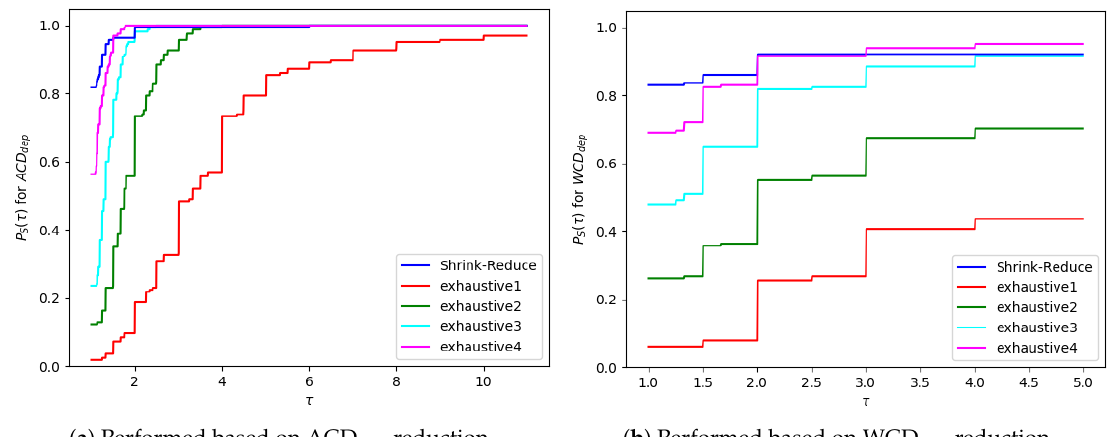
Figure 17. Results for all action replacement experiments. When τ is further increased, there is no change in P s ( τ ) ; unless τ = ∞ , then P S ( τ ) = 1 for all